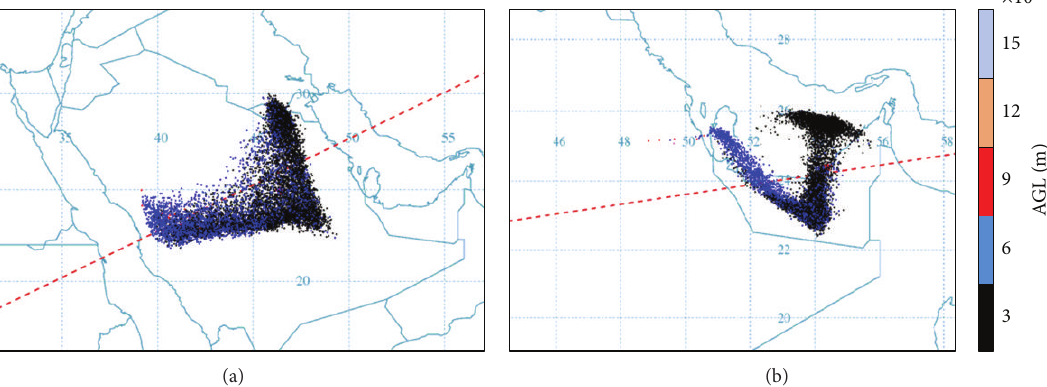
Figure 6: HYSPLIT backward trajectory dispersion starting from (a) Solar Village, (b) MASDAR ends on March 09, 2009 13:00UTC. Heights are indicated by the legend bar.